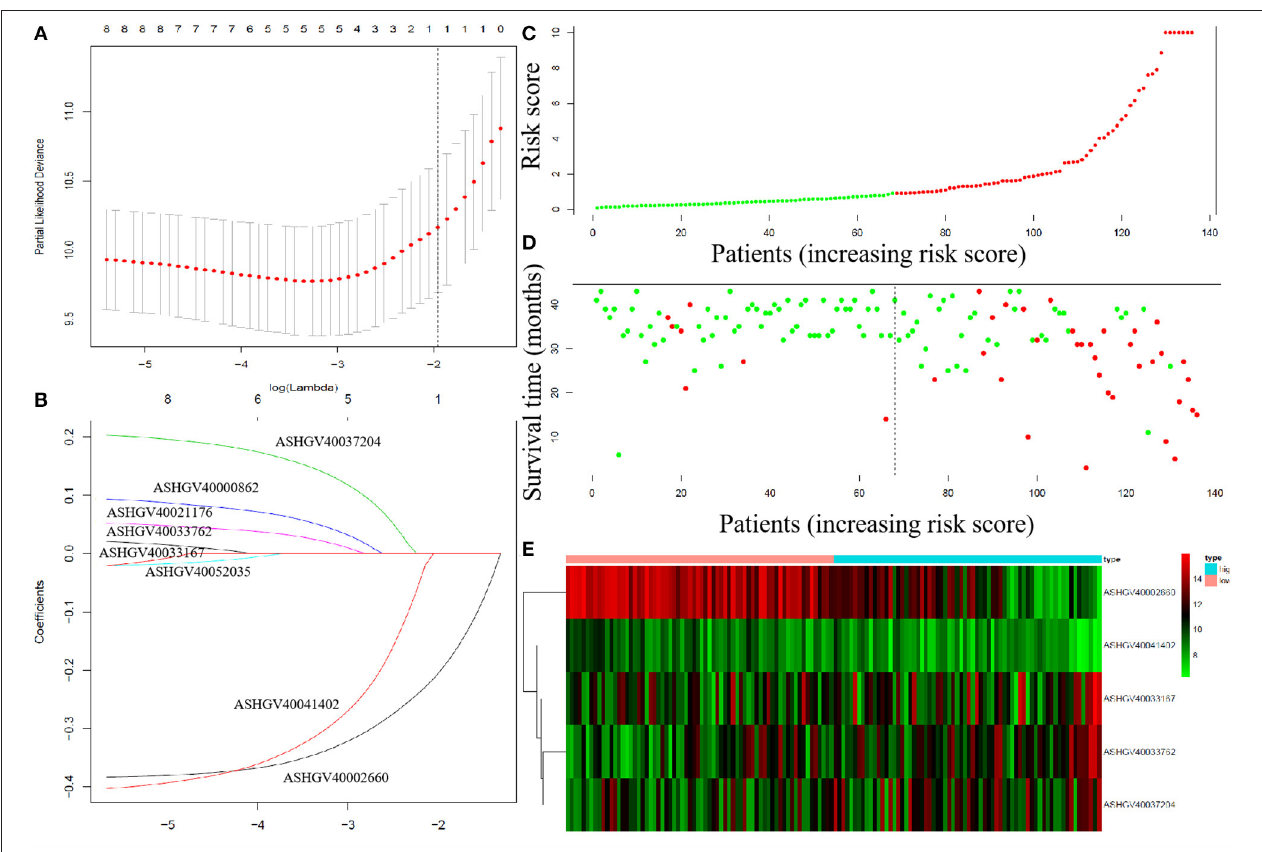
FIGURE 7 | The least absolute shrinkage and selection operator (LASSO) analysis and risk score system were constructed. (A) The area under the ROC curve (AUC) was estimated with a cross-validation technique, and the largest lambda value was chosen when the cross-validation error was within one standard error of the minimum. (B) LASSO coefficient profiles of the eight factors. (C–E) The risk factor model of the hub lncRNAs in the non-metastatic CRC patients. (C) Long non-coding RNAs (lncRNAs) risk score distribution of 136 CRC patients. (D) Survival status in non-metastatic CRC patients ( N = 136). (E) Heatmap of the hub lncRNAs expression. Red: high expression; blue: low